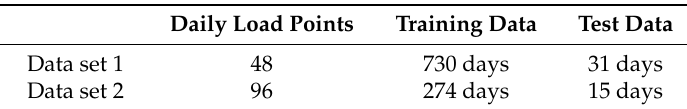
Table 2. Experimental dataset